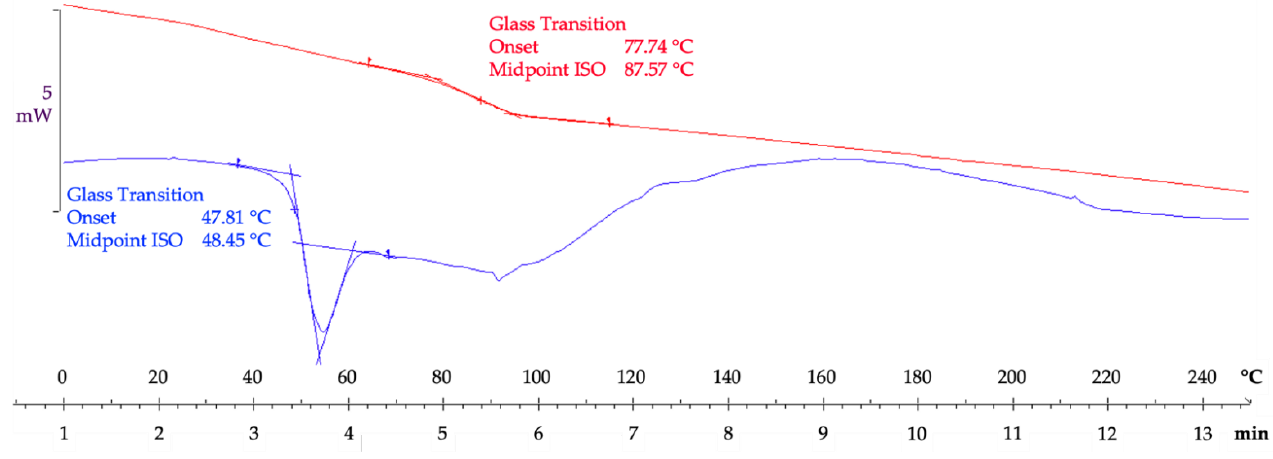
Figure 5. Glass transition temperature of the epoxy